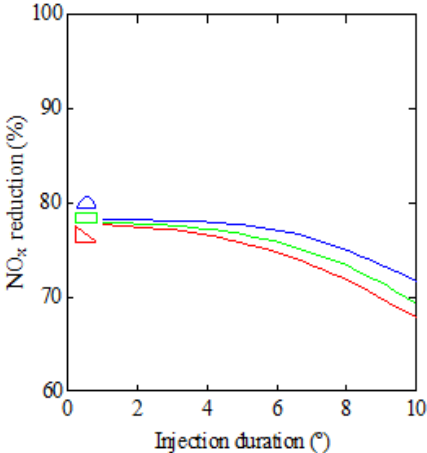
Figure 9. NO x reduction against the duration of injection for rectangular (green color), triangular (red color), and parabolic (blue color) injection shapes.